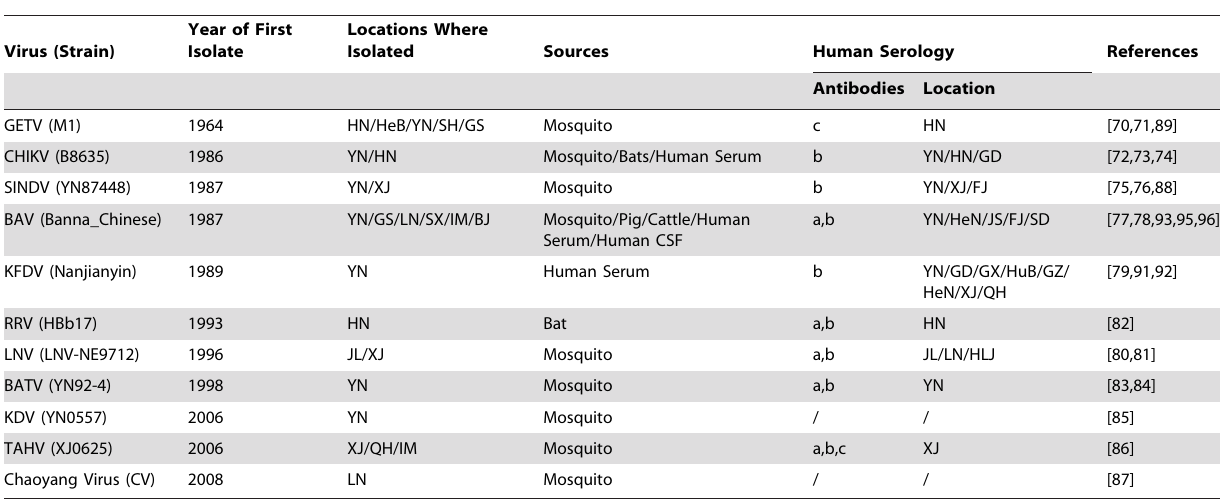
Table 1. Arbovirus isolates and evidence of human infection in mainland